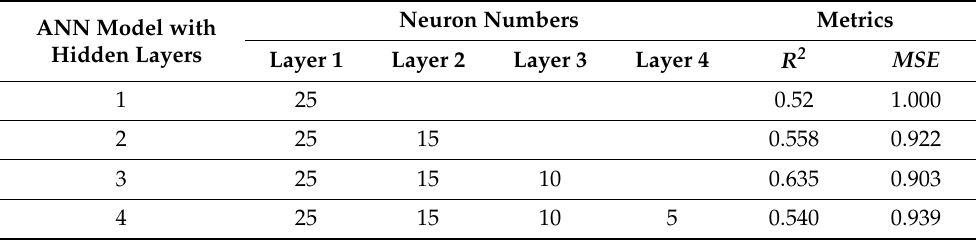
Table 4. Predicted performances of all ANN models with variant hidden